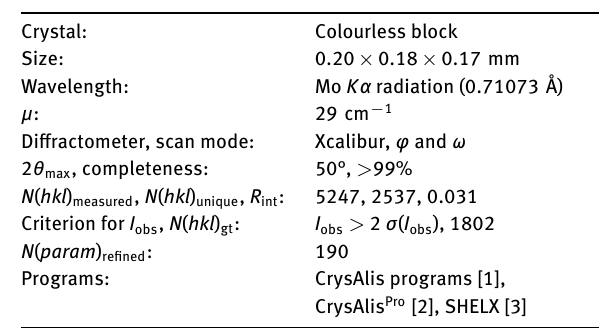
Table 1: Data collection and handling.